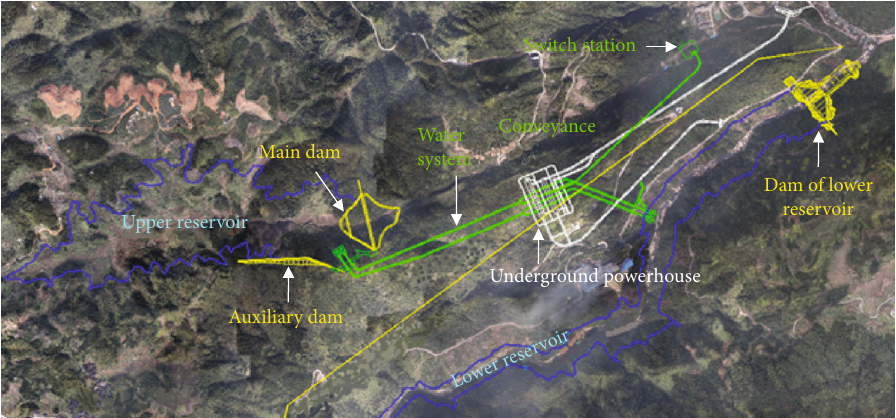
Figure 1: Topography and building layout of the Zhouning pumped storage power